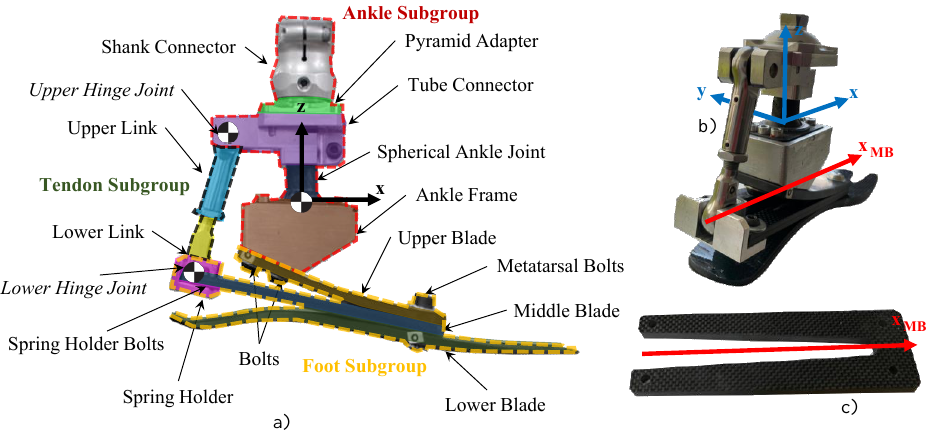
Figure 1. ( a ) MyFlex- δ parts and subgroups; ( b ) picture of MyFlex- δ ; ( c ) shape of the middle